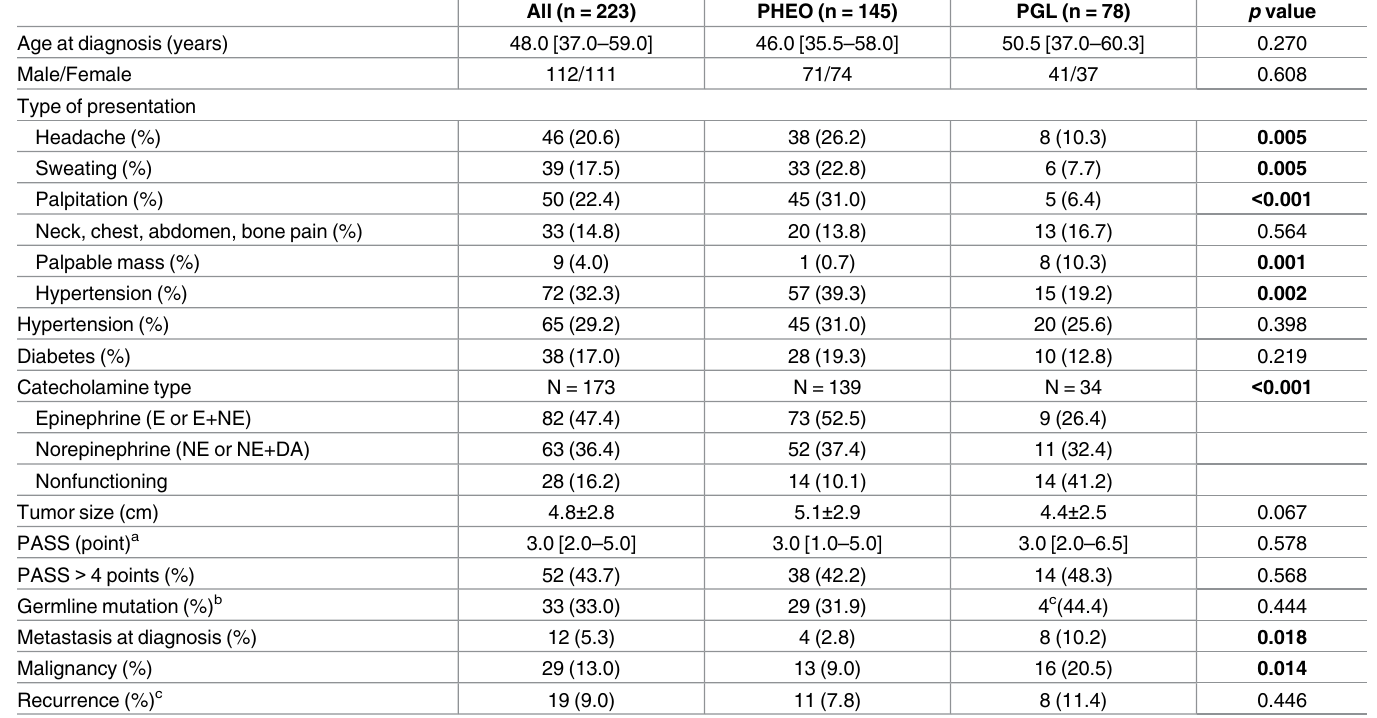
Table 1. Clinical and pathological characteristics of patients with PHEO and